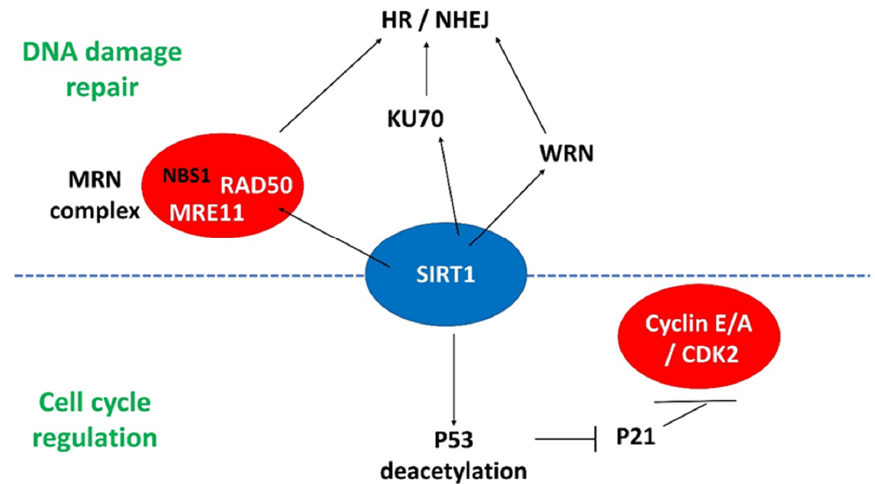
Figure 2. The interactions of SIRT1 with different regulators involved in DNA damage repair and cell cycle progression. MRN complex: MRE11/RAD50/NBS1; HR: homologous recombination; NHEJ: non-homologous end joining.